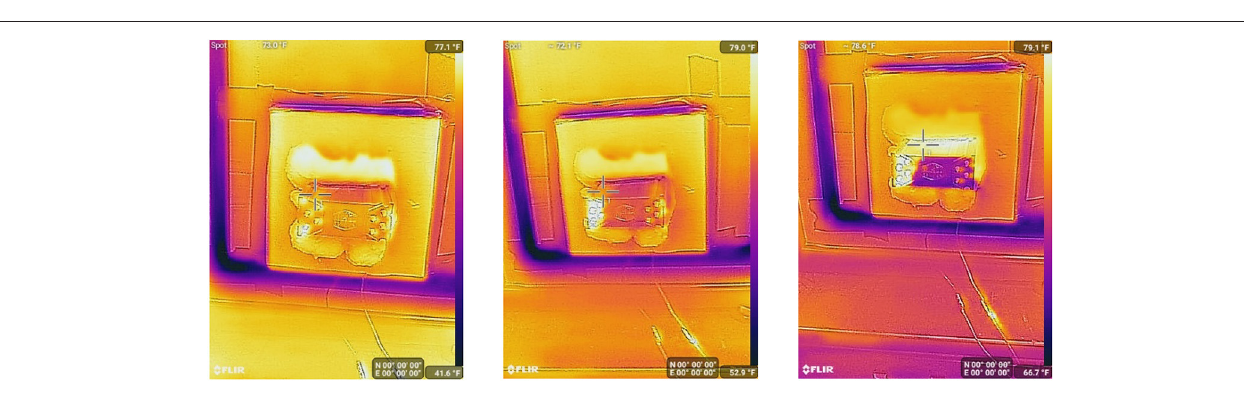
FIGURE 9 | Assembly heating at − 17.8 ◦ , − 1.1 ◦ and 15.6 ◦ C (0 ◦ , 30 ◦ , and 60 ◦ F) with 3V